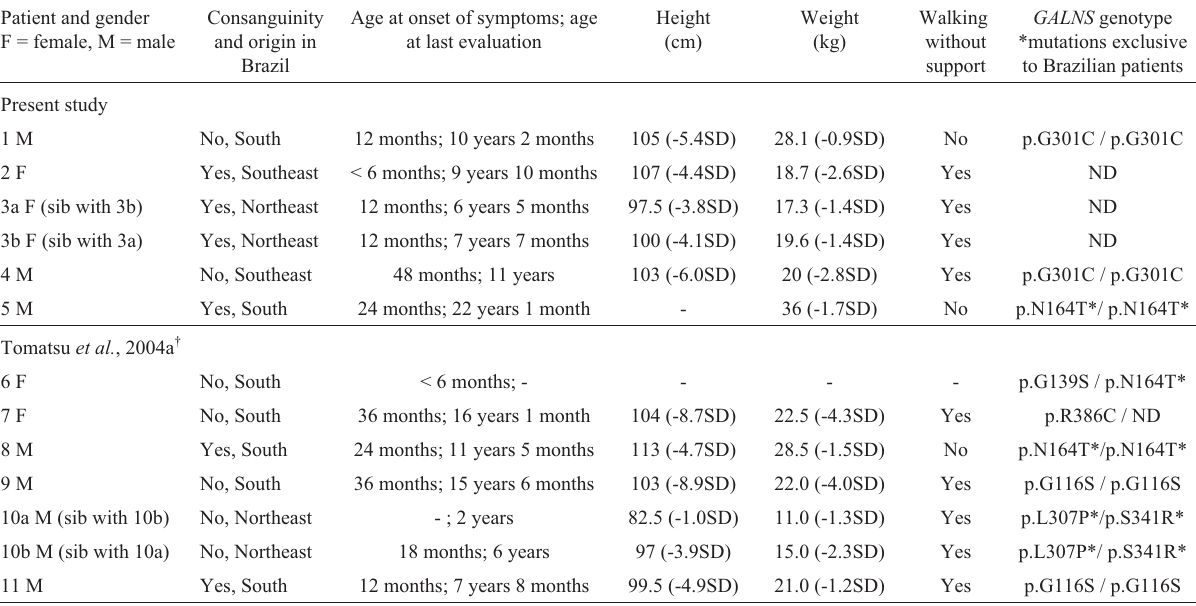
Table 1 - Clinical and genetic data for Brazilian patients with mucopolysaccharidosis (MPS) IVA. Patients 1 to 5 were analyzed by us for exons 4, 5, 9 and10oftheN-acetylgalactosamine-6-sulfatesulfatase( GALNS )geneexon.Patients6to11correspondtopatients17,16,18,19,15and14investigated by Tomatsu et al. (2004a) † and were analyzed regarding all the GALNS gene exons. Patients 3a and 3b, and 10a and 10b were sibs. The standard devia- tions(-SD)wereascomparedtoage-matchednormalcontrols(datafromtheNationalCenterforHealthStatisticsathttp://www.cdc.gov/nchs)andrepre- sent the number of standard deviations by which the patients are smaller or lighter than the controls, hence the negative values. A dash (-) indicates that data was not available, ND = not detected. Patient and gender Consanguinity Age at onset of symptoms; age Height Weight Walking GALNS genotype F = female, M = male and origin in at last evaluation (cm) (kg) without *mutations exclusive Brazil support to Brazilian